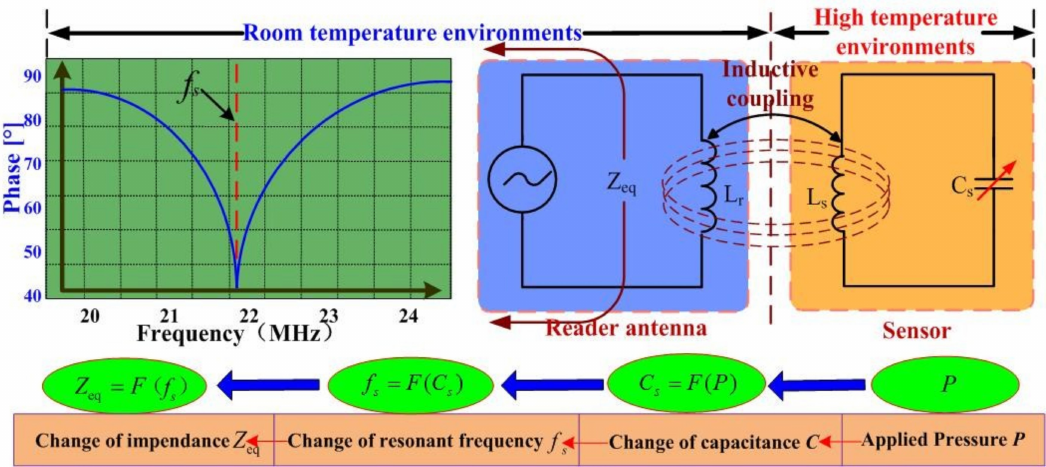
Figure 5. High temperature pressure-sensitive principle of